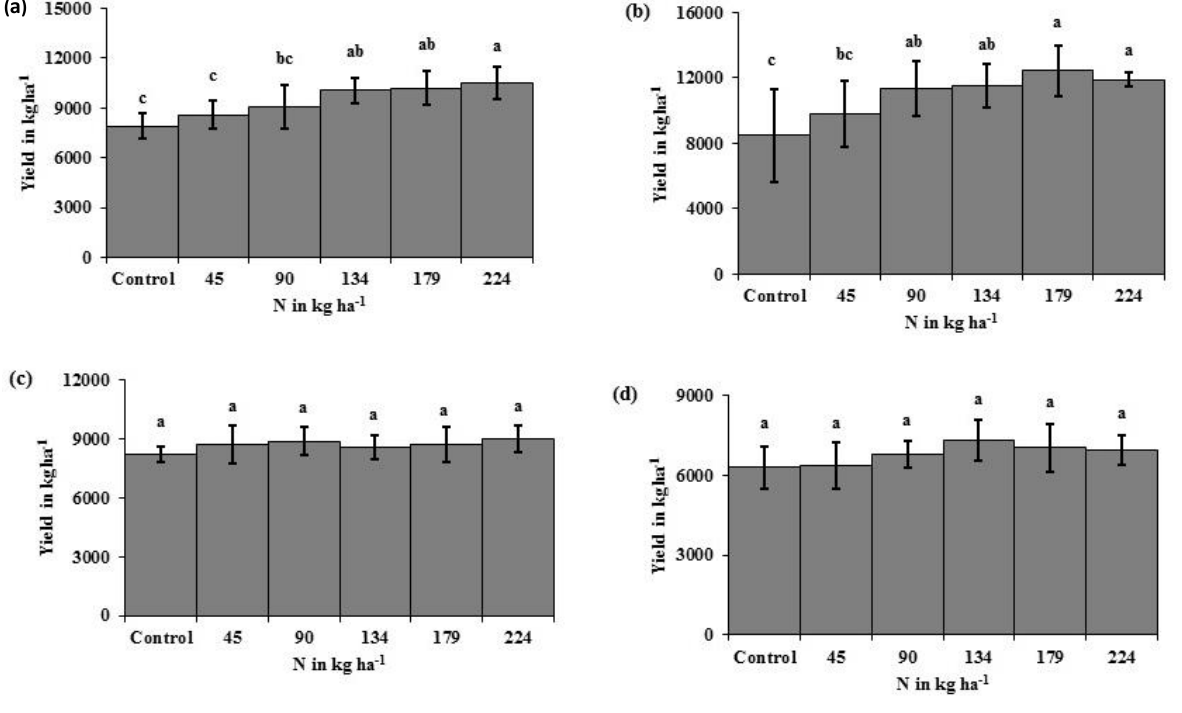
Figure 1. Corn yield difference in response to N fertilizer rates under high clay conventional-till ( a ); medium textured conventional-till ( b ); eastern ND no-till ( c ); and western ND no-till ( d ) sites. Bars with different letters indicate significance at p < 0.05. Bars represent the range of yields within each N